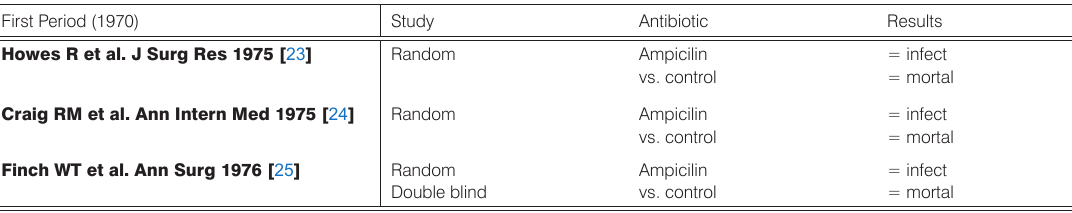
Table 3. Second period in prophylactic antibiotics